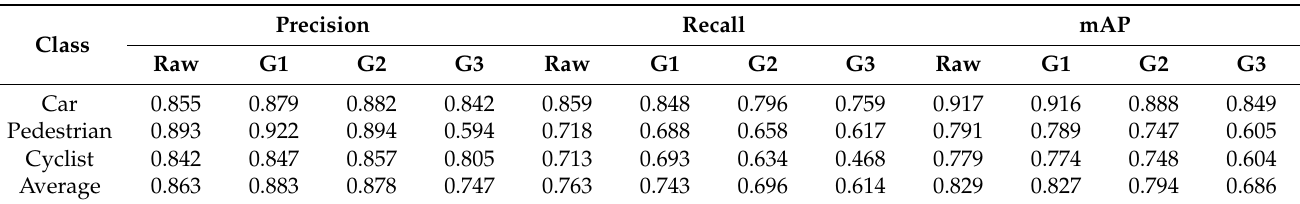
Table 9. Evaluation metrics for KITTI point cloud data compressed at different degrees, converted with the Delaunay Triangulation and evaluated using the best YOLOv5m model, trained over the course of 200 epochs with a batch size of